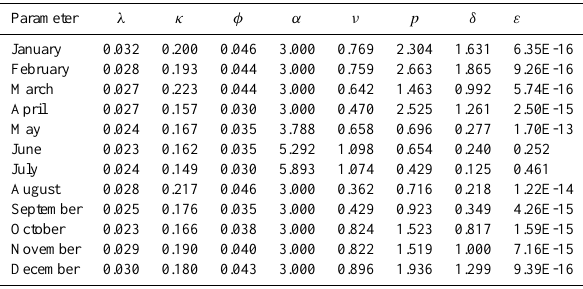
Table A5. Parameter set used for the TBLG